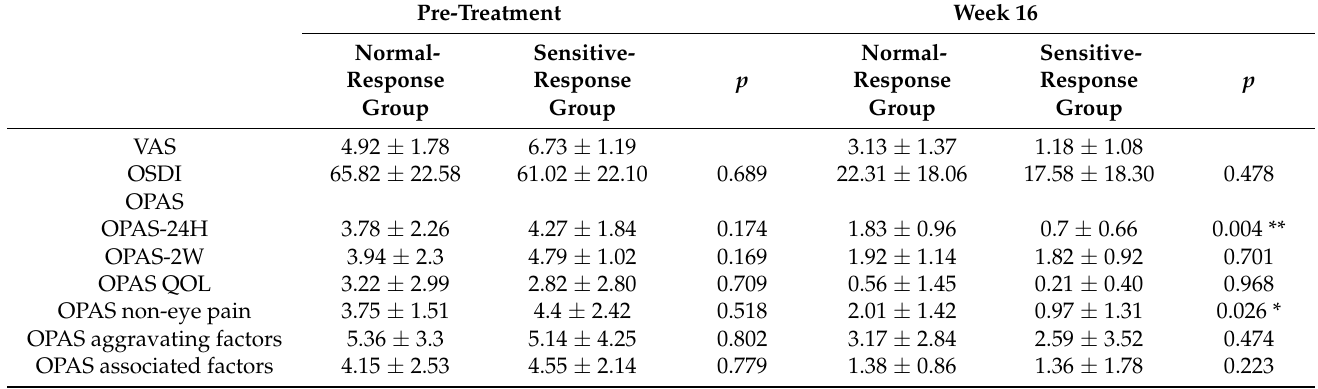
Table 2. Changes of factors affect VAS scores after IPL combined DCBE eye drops treatment in DED patients with ocular pain.